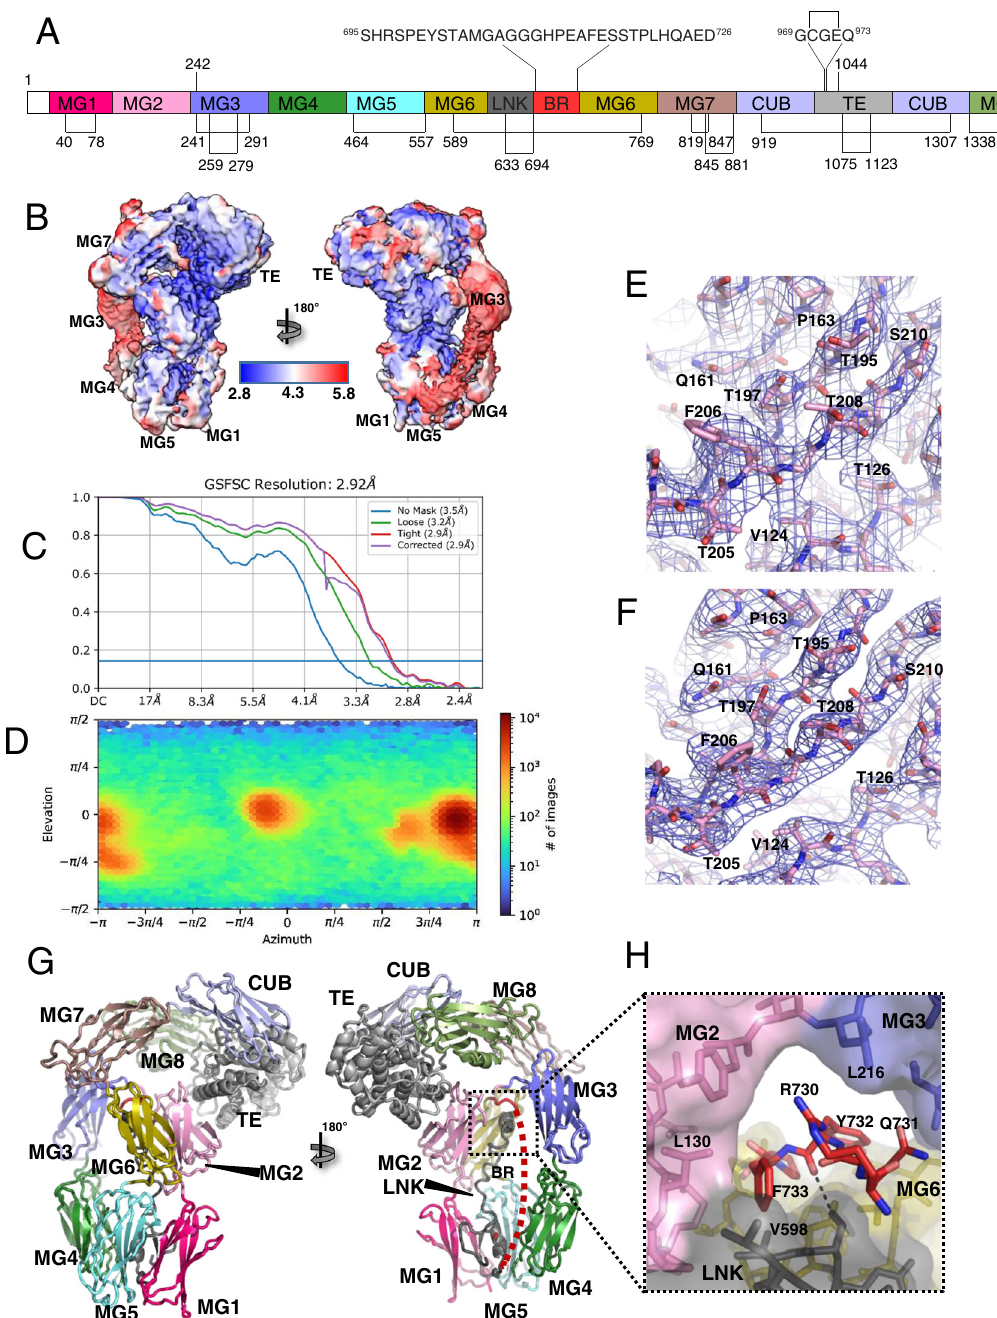
Fig. 2 Structures of native A2ML1. A Schematic representation of the domains of A2ML1 with disul fi des and the internal thioester indicated. Notice that the LNK and BR are inserted in the MG6 domain, whereas the TE domain is inserted in the CUB domain. The MG8 domain is also known as the receptor- binding domain, RBD. B Local resolution of the native A2ML1 cryo-EM map in two orientations. C Fourier shell correlation indicates a resolution of 2.9 Å. D The plot of the particle orientation distribution demonstrates the presence of preferred orientations. E Example of EM map quality for native A2ML1 for residues in the MG2 domain. F As in panel E , but displaying the X-ray map obtained after molecular replacement and density modi fi cation at 4.4 Å resolution. G Native A2ML1 in a cartoon representation. The domains are colored as in panel A . To the right, the dashed red line indicates fl exible BR residues not modeled. H Close-up on the inter-domain channel accommodating the C-terminal residues of the bait